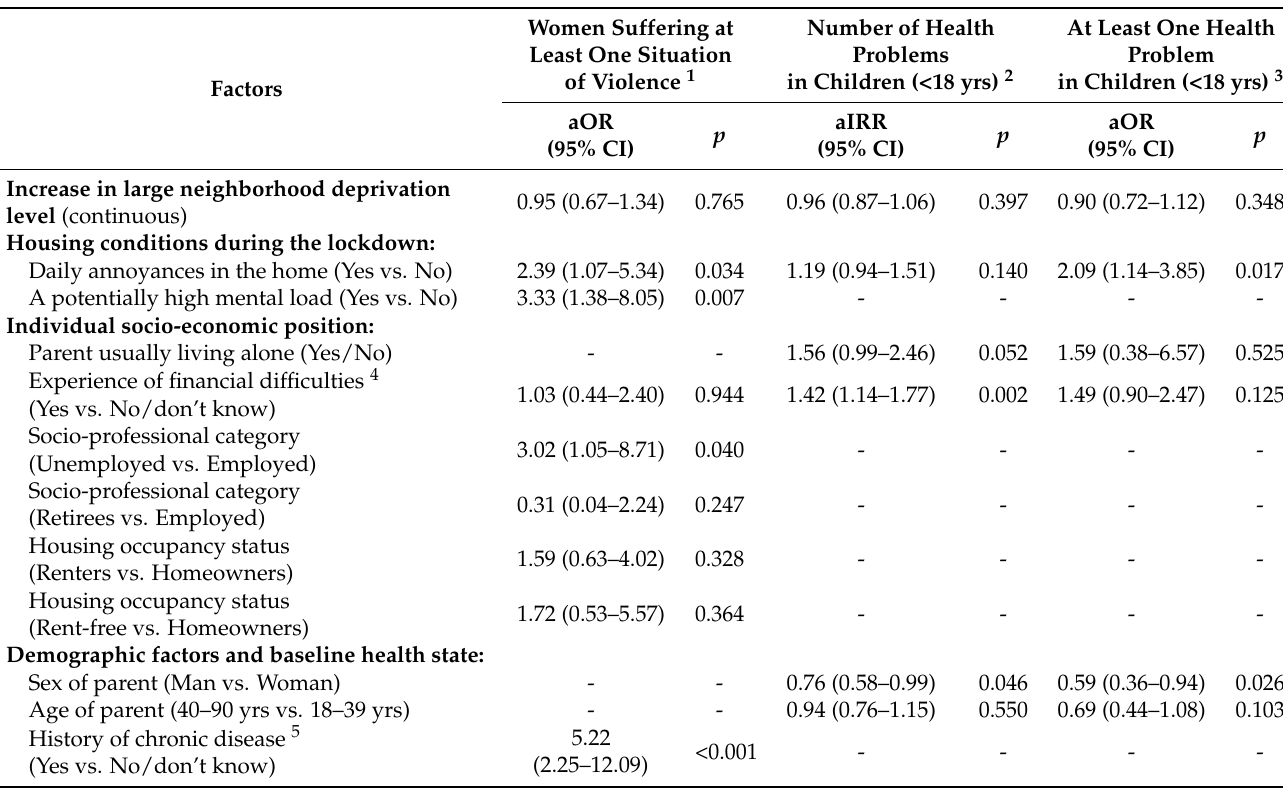
Table 7. Factors independently associated with economic or psychological violence against women and health problems in children during the COVID-19 lockdown (R é -Conf-ISS cross-sectional study: Reunion Island, 13 May and 22 July 2020)—fully adjusted multivariable models